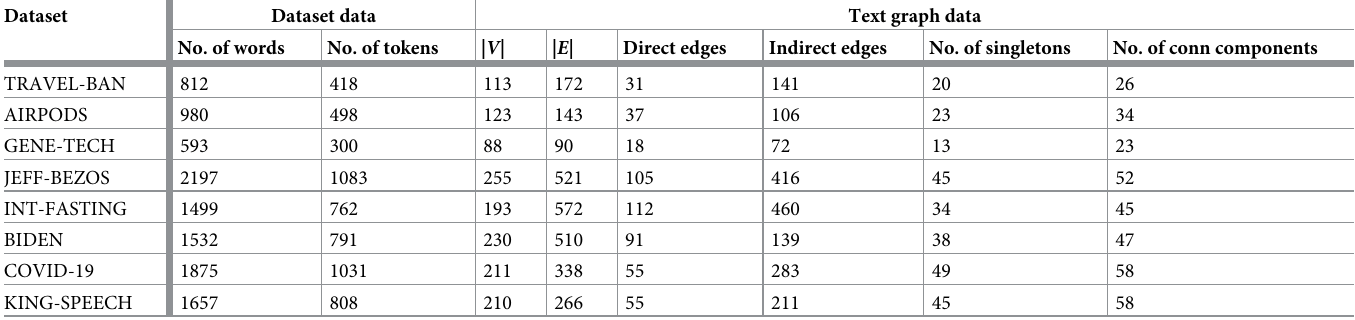
Table 6. Statistical and text graph data of each dataset. Number of words and number of tokens denote the number of words in the dataset before and after preprocessing respectively. Direct edges and indirect edges represent the number of direct and indirect synonym relationships between words in the text graph respectively.